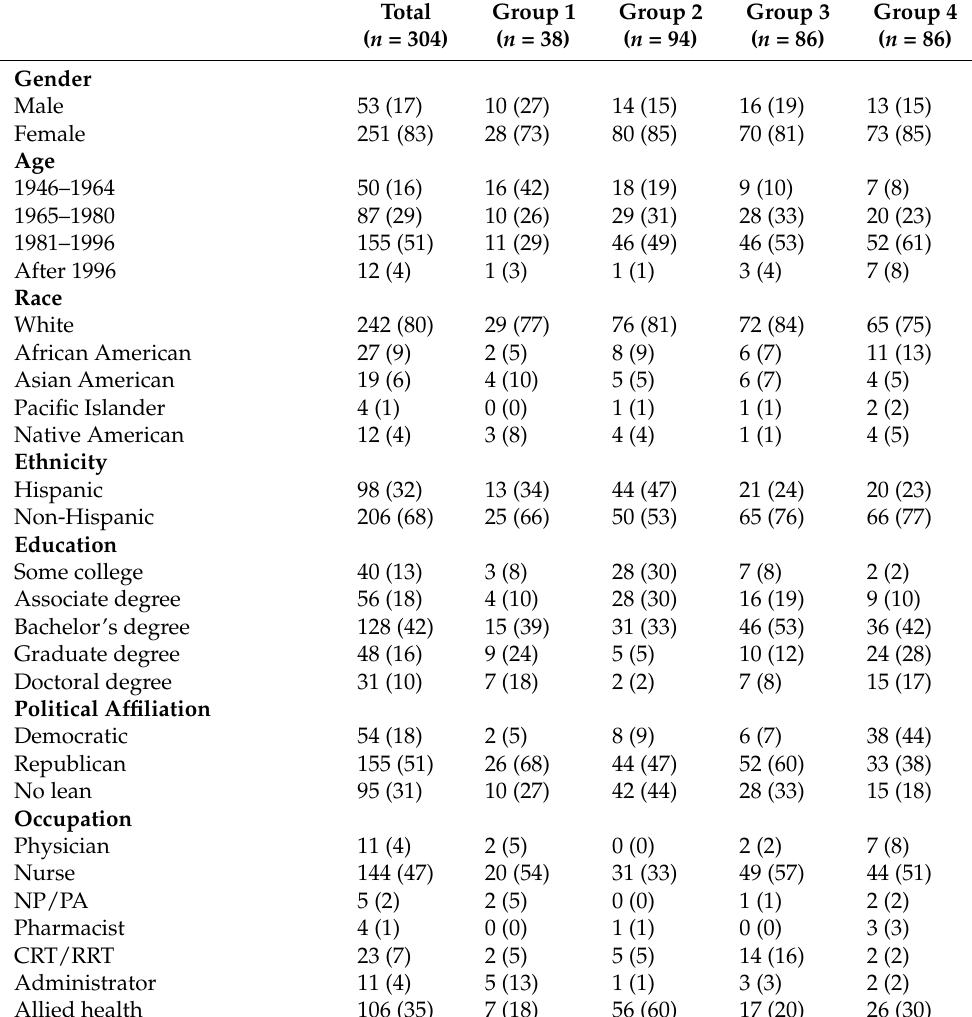
Table 5. Characteristics of four